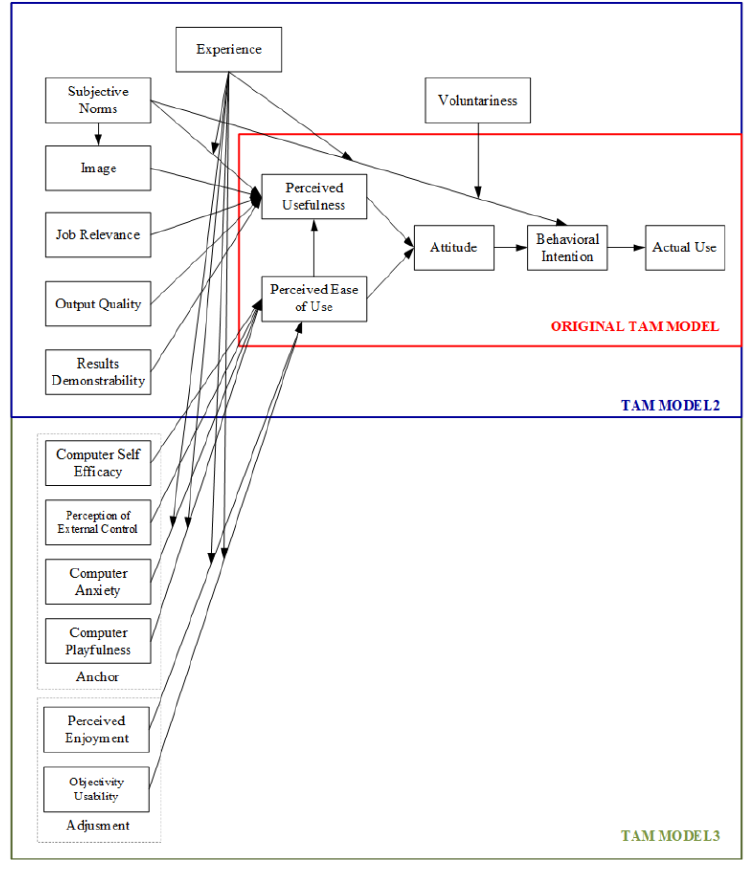
Figure 1: TAM Model Evolution; Source: